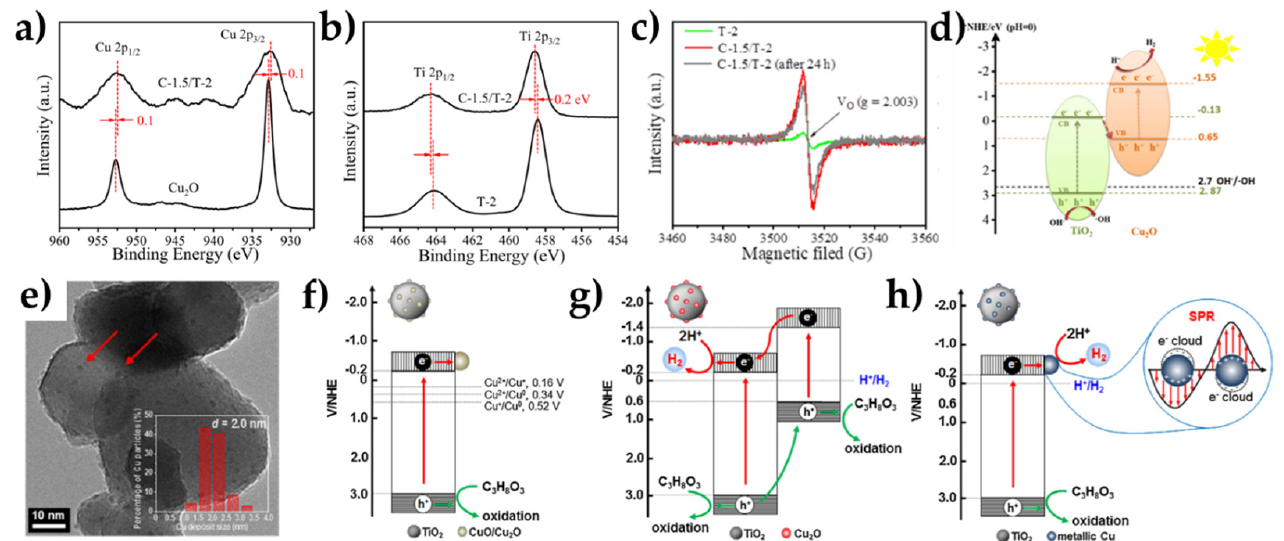
Figure 8. ( a , b ) XPS spectra of Cu 2p of Cu 2 O and C − 1.5/T − 2 and Ti 2p of T − 2 material, respectively. For C − 1.5/T − 2 nanocomposite we observe a negative shift of 0.1 eV (binding energy of Cu 2p) and a positive shift of 0.2 eV (binding energy of Ti 2p) indicating that the electron density of Ti (IV) decreases and that of Cu(I) increases, which may indicate a directional carrier transfer from TiO 2 to Cu 2 O; ( c ) ESR spectra of T − 2, C − 1.5/T-2 and C − 1.5/T − 2, where the characteristic O V signal can be